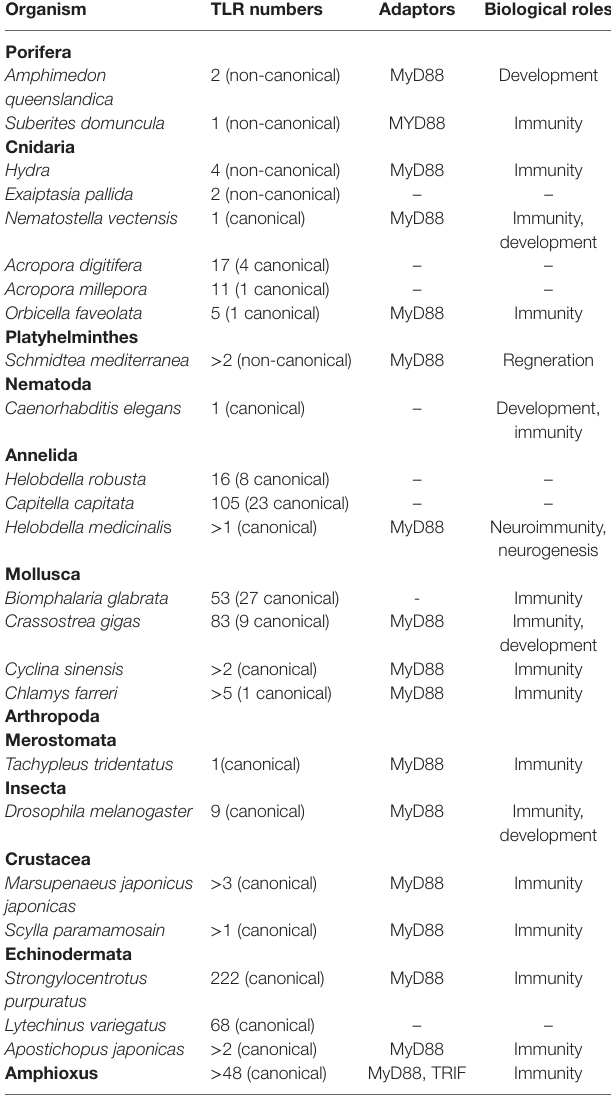
TABLe 1 | Summary of toll-like receptors (TLRs) in invertebrates and amphioxus.